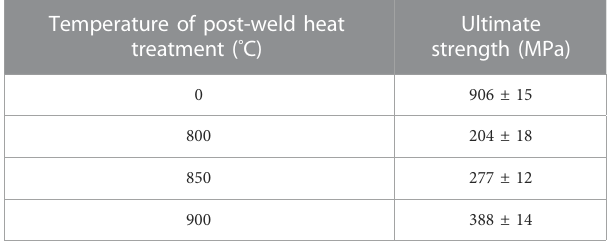
TABLE 1 Ultimate strength of the weld joints of Ti-22Al-25Nb alloy before and after post-weld heat treatment. Temperature of post-weld heat treatment ( ° C)